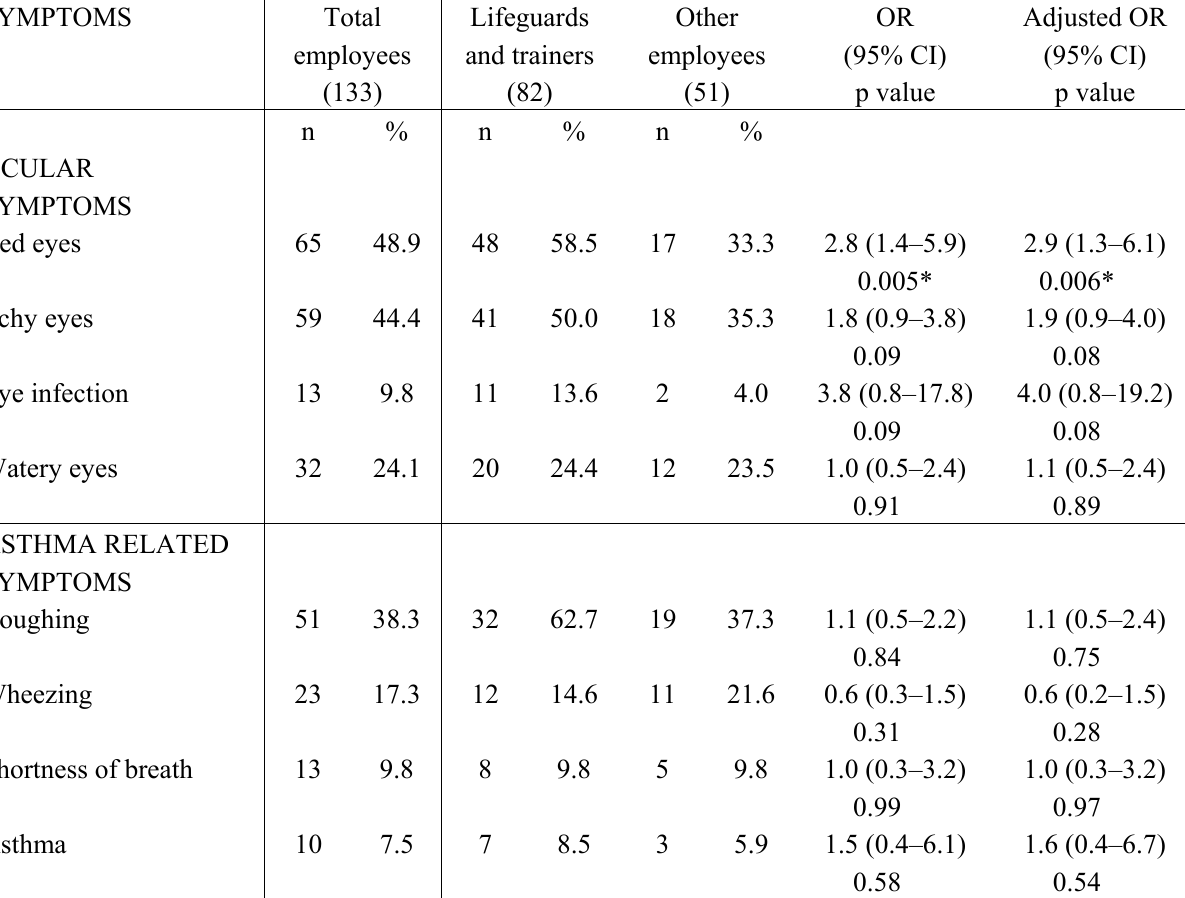
Table 2. Prevalence of ocular, cutaneous, asthma-related and other respiratory symptoms in the 133 occupationally exposed